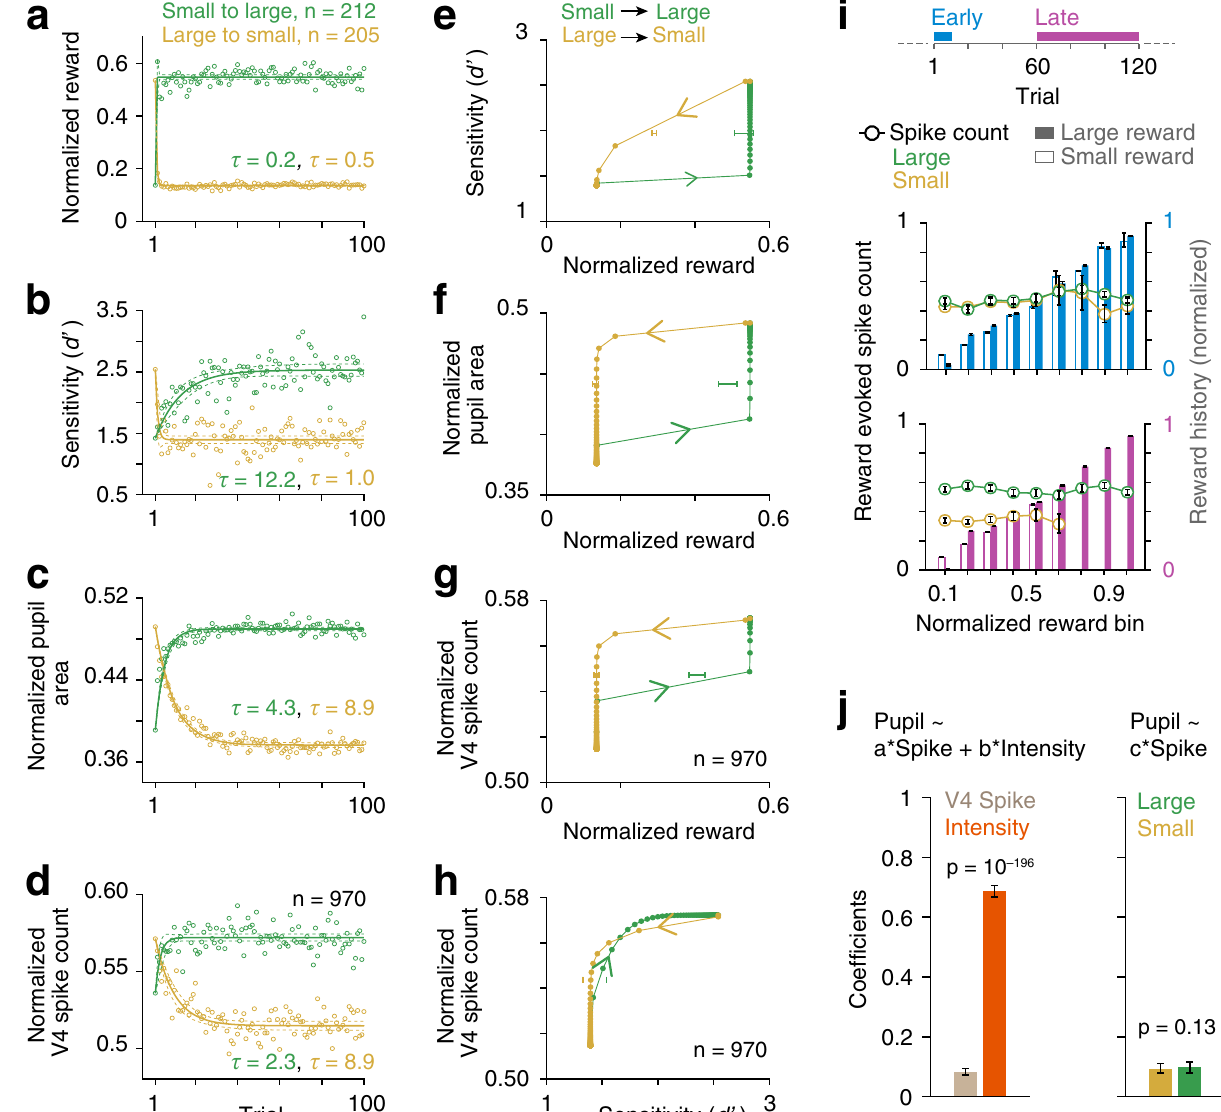
Fig. 5 Directions of reward change have differential delayed effects on behavior and physiology. Block-averaged single received rewards ( a ), behavioral sensitivity ( d ′ ) ( b ), normalized mean pupil area during sample stimulus period ( c ), and normalized V4 spike counts across all neurons ( n = 970; ( d )) in large ( n = 212) and small ( n = 205) reward blocks. Circles, observed data. Lines, single exponential fi ts. τ , decay or rise constants. Trials are aligned with respect to the fi rst correct trial following block transition. Dashed lines, 95% con fi dence intervals. e – g Hysteresis with transition of attentional intensity. Behavioral d ′ ( e ), pupil area ( f ), and V4 spike counts ( g ) in response to reward changes from large to small and reverse. Horizontal error bars, mean ± SEM of reward size across blocks at the center value of y -axis variable. h V4 spike counts as a function of d ′ changes. Vertical lines, mean d ′ across blocks at the half-value of spike counts. i Top, analysis windows for reward-matched V4 spike counts in large- and small-reward blocks within fi rst 10 trials at the beginning (middle, cyan) and last 60 trials at the end of blocks (bottom, purple). Bars, mean received rewards across trials binned between 0 and 1 (bin size = 0.2, overlap = 0.1; within session normalized) for two reward block conditions. Data are presented as mean with 95% con fi dence intervals (bootstrap, n = 10 4 ). Circles, mean normalized spike counts ( n = 970) on immediate next trial. j Left, linear regression between mean pupil area (0 – 400 ms), spike counts (60 – 260 ms), and reward conditions (high and low attentional intensities) across all trials were fi t separately for each neuron. Population mean ± SEM of fi tted coef fi cients of intensity was signi fi cantly higher compared to the coef fi cients of spike counts ( p = 10 − 196 ; rank sum test) for neurons with signi fi cant fi t ( p < 0.05, n = 625; F -test). Right, two separate linear regression fi ts between pupil area and spike counts for large- and small-reward trials. Mean± SEM of fi tted coef fi cients of spike counts for the two reward conditions for neurons with signi fi cant fi t ( p < 0.05, n = 334; F -test) were not different ( p = 1.3; rank sum